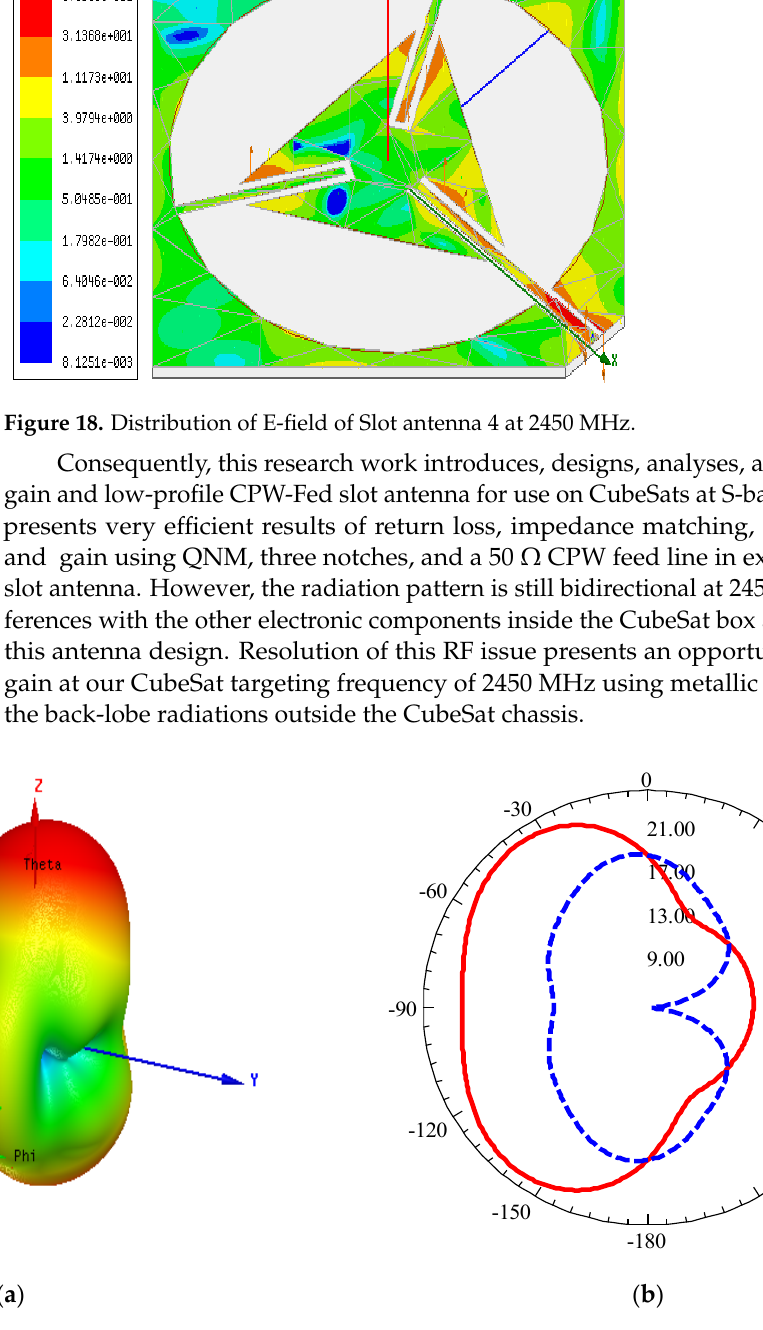
Figure 19. 3D gain, E- and H-fields of Slot antenna 4 at 2450 MHz: ( a ) 3D gain plot at 2450 MHz; ( b ) E- and H-fields at 2450 MHz.